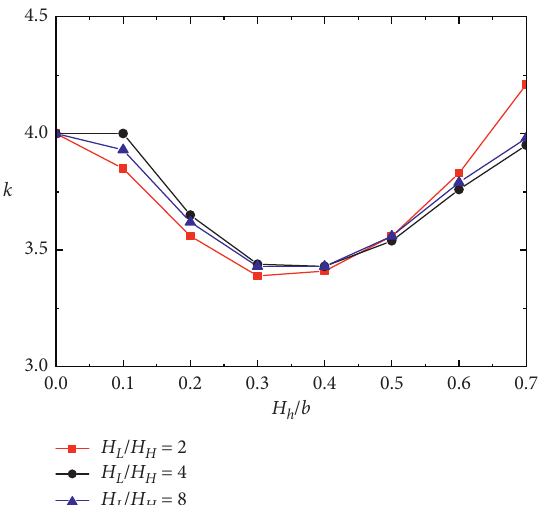
Figure 21: Buckling coefficient of plates with rectangular